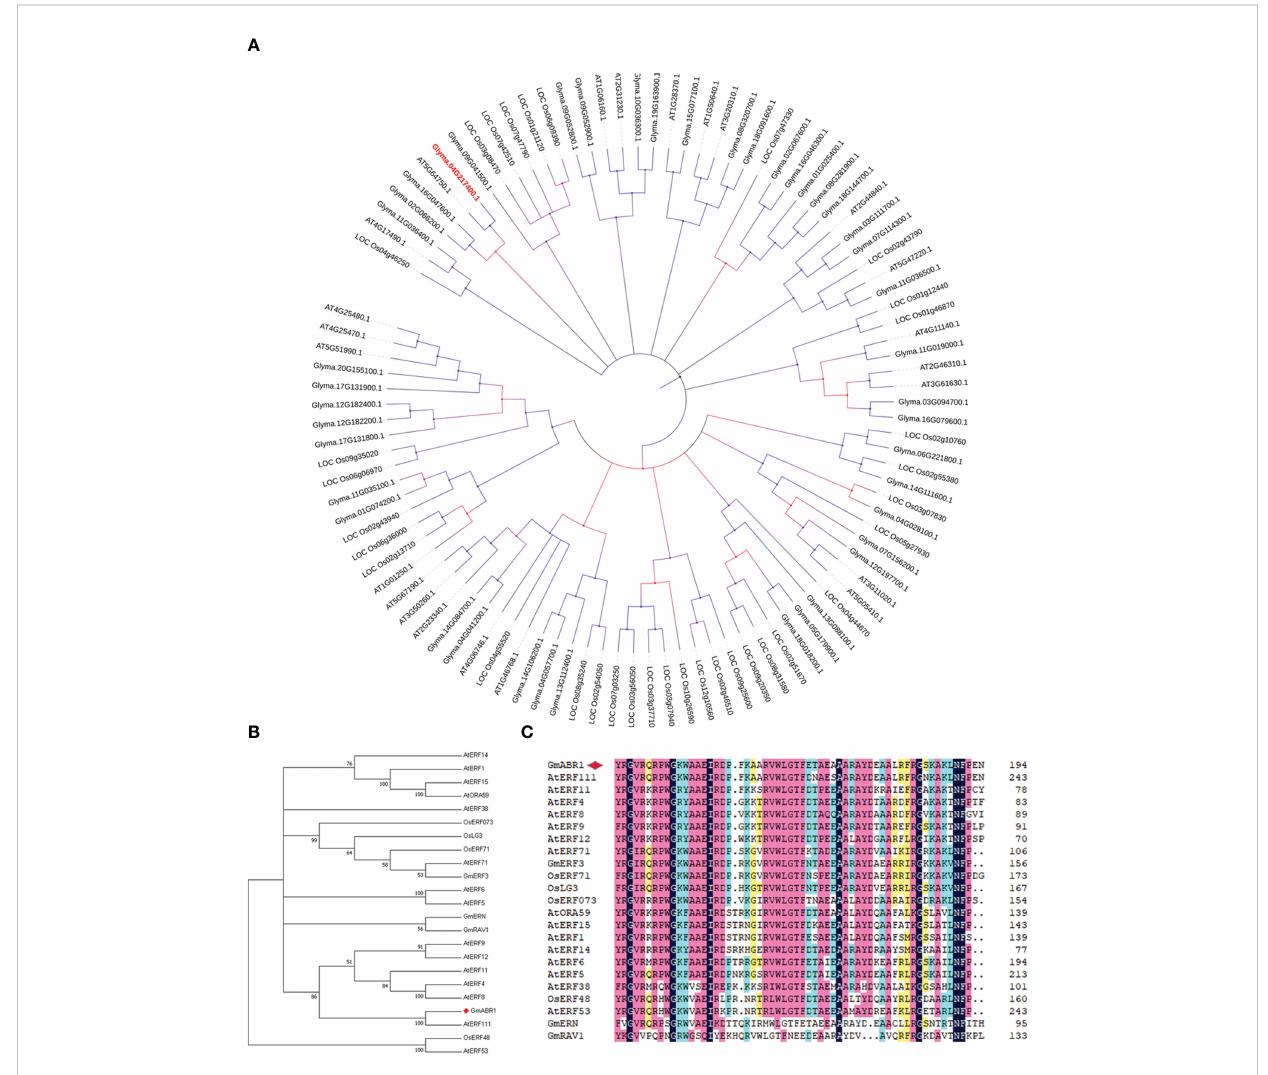
FIGURE 1 Amino acid sequence and phylogenetic analysis of ERF transcription factors. (A) Phylogenetic tree analysis of GmABR1 and ERF proteins in representative species of major lineage of plants. (B) Phylogenetic analysis of ERF proteins in higher plants. (C) Sequence alignment of the AP2 domain in ERF proteins of higher plants. The comparison of amino acid sequences was conducted by the software of DNAMAN9.0. The phylogenetic tree was constructed by the neighbor-joining method using the software of MEGA 7.0. The above involves the amino acid sequences of ERF family from the NCBI database (https://www.ncbi.nlm.nih.gov/). The detailed information of ERF proteins was available from the Table